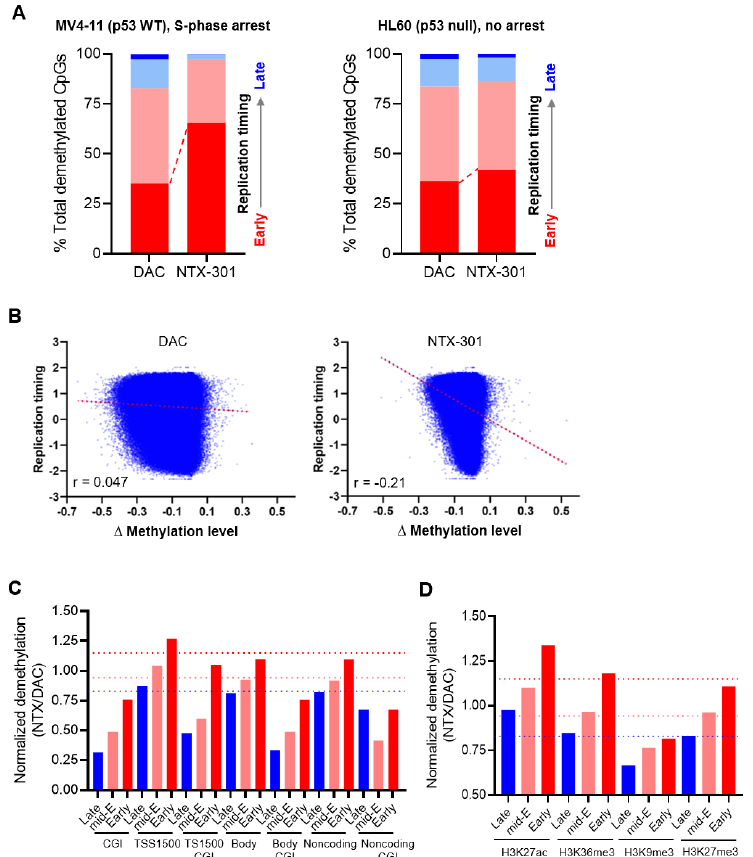
Figure 7. NTX-301 promoted characteristic demethylation patterns. ( A ), Plots showing the distribu- tion of CpGs that were demethylated after treatment with NTX-301 or DAC in four genomic regions annotated by replication timing from early (red) to late (blue) in MV4-11 (left) and HL-60 (right) cells. ( B ), Scatter plots showing differential methylation levels ( ∆ methylation level = on-treatment level − basal level) plotted against replication timing in MV4-11 cells. Correlation coefficients (r) are shown. ( C , D ), Bar plots showing the normalized ratio of NTX-301-mediated demethylation to DAC- mediated demethylation in several genomic ( C ) and chromatin ( D ) features. The red, pink, and blue dotted lines denote the normalized baselines of the demethylation ratio in genomic regions with early, mid-early (mid-E), and late replication timing, respectively. CGI, CpG island; TSS1500, the region 1500 bp upstream of the transcription start site.